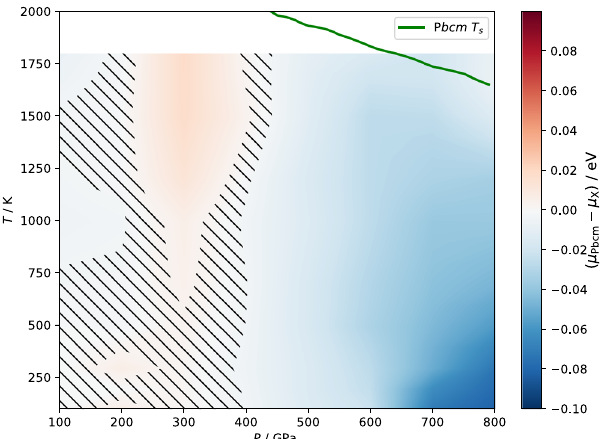
Fig. 4 | High-pressure phase diagram. The chemical-potential difference μ P bcm − bcm and X as a function of temperature and μ X per formula unit (f.u.) between P pressure. The statistical error in the chemical-potential difference results in the uncertainty of the coexistence line, which is indicated by the hatched area. The greencurveshowstheinsulating – superionictransitiontemperature T s de fi nedbya threshold of proton diffusivity ( D H >10 − 8 m 2 s − 1 ) for the P bcm